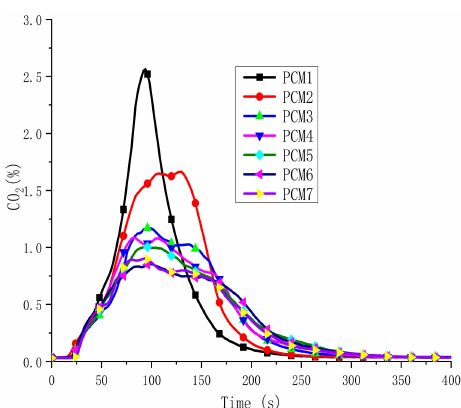
Figure 10. CO evolved in PCMs.